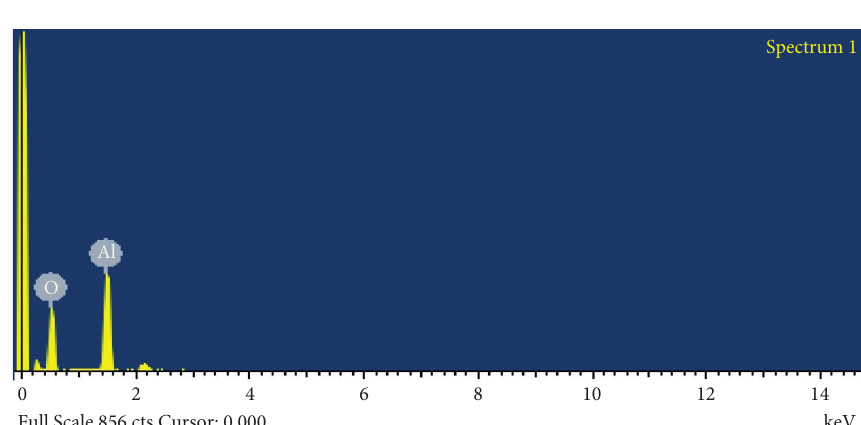
Figure 1: Elemental composition present in Al